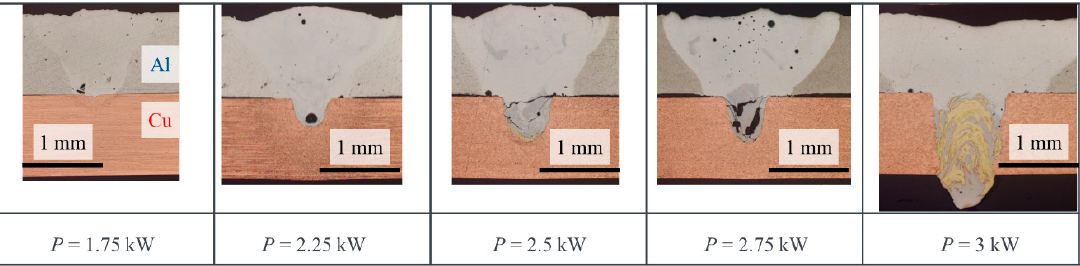
Figure 5. Micrographs of cross-sections of welds produced with conventional rectilinear welding, v feed = 6 m/min.